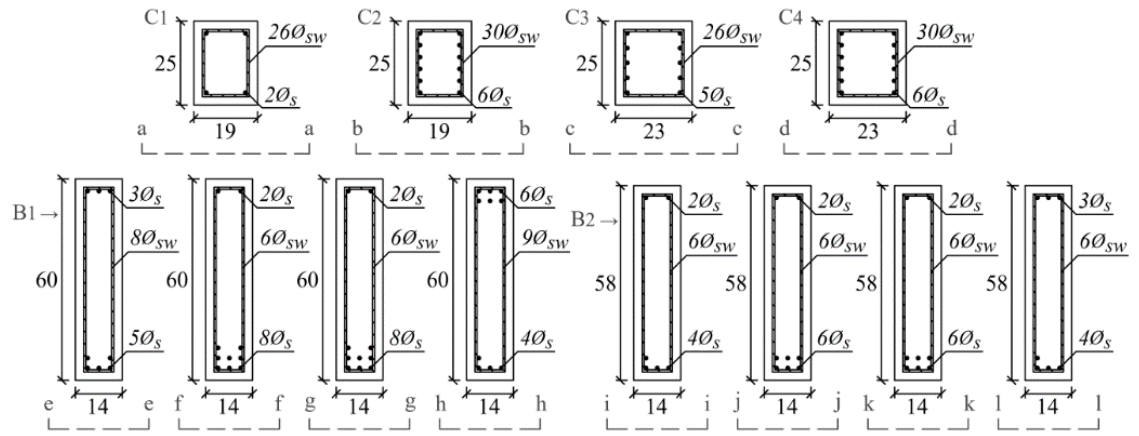
Figure 6. Detailing the optimal sections (dimensions in cm) - Example I: case